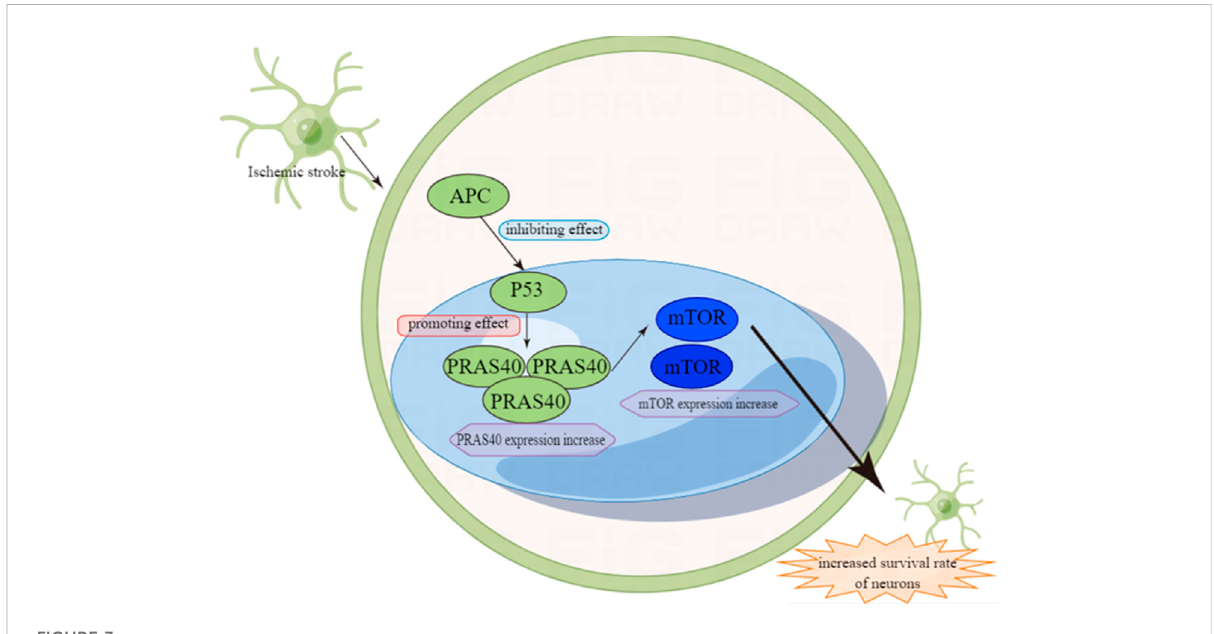
FIGURE 3 The role of P53 in ischemic